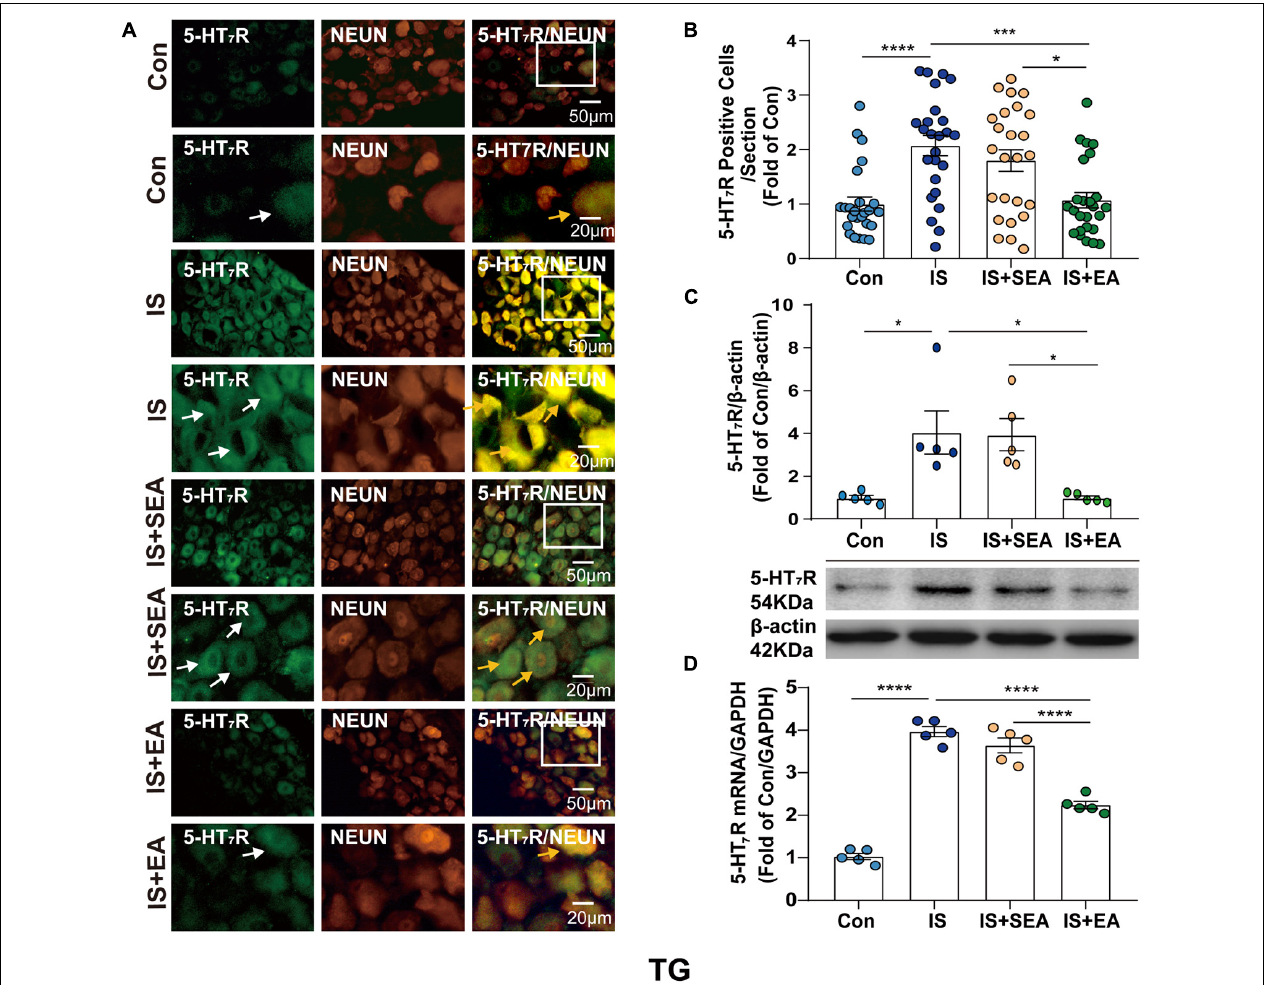
FIGURE 4 | Effects of EA on the endogenous 5-HT 7 R in the TG on day 8 after the 4th IS injection. (A) Immunofluorescence showed that 5-HT 7 R (green) was expressed mostly in the individual neurons (NeuN, Neuron marker, red) of the TG. The upper panel displays the expression of 5-HT 7 R at low magnification, and the lower panel displays the expression of 5-HT 7 R in the TG at high magnification in each group. The white and orange arrows point to the positive cells in TG. Scale bars = 50 or 20 µ m. (B) Quantitative analyses of 5-HT 7 R to evaluate the numbers of positive cells ( n = 5, five sections/animal). (C) Representative western blot bands and quantitative analyses of 5-HT 7 R. The same membranes were probed for 5-HT 7 R with β -actin; ( n = 5). (D) The mRNA levels of 5-HT 7 R were also accessed by real-time polymerase chain reaction, and values were corrected by GAPDH in TG ( n = 5). One-way ANOVA followed by post hoc Tukey test. Group values are indicated by mean ± SEM. * P < 0.05, *** P < 0.001, **** P < 0.0001. 5-HT 7 R, 5-hydroxytryptamine (5-HT) 7 receptor; GAPDH, glycolytic enzyme glyceraldehyde 3-phosphate dehydrogenase; TG, trigeminal ganglion; EA, electroacupuncture; IS, inflammatory soup; SEA, sham electroacupuncture; Con,